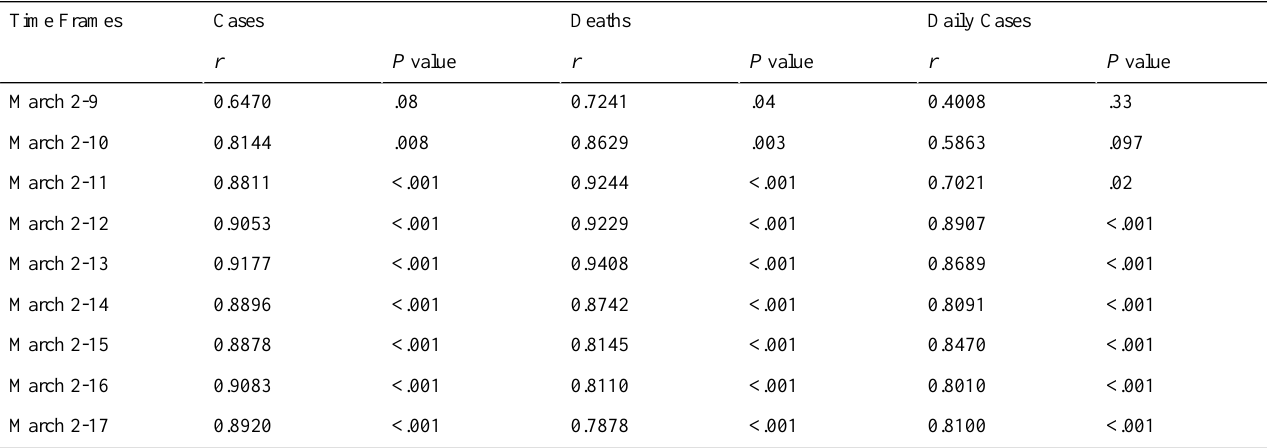
Table 5. Pearson correlation coefficients ( r ) between COVID-19 cases and deaths and Google Trends data for the United Kingdom.